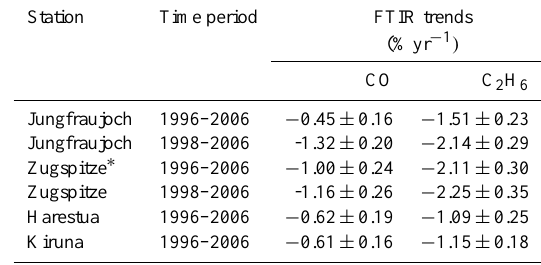
Table 7. Average values ( µ) from March to December for the FTIR measurements, global-scale (Gc) model and European-scale (E) model. January and February data are excluded from the µ val- ues because of the strong influence from the initital conditions in the global